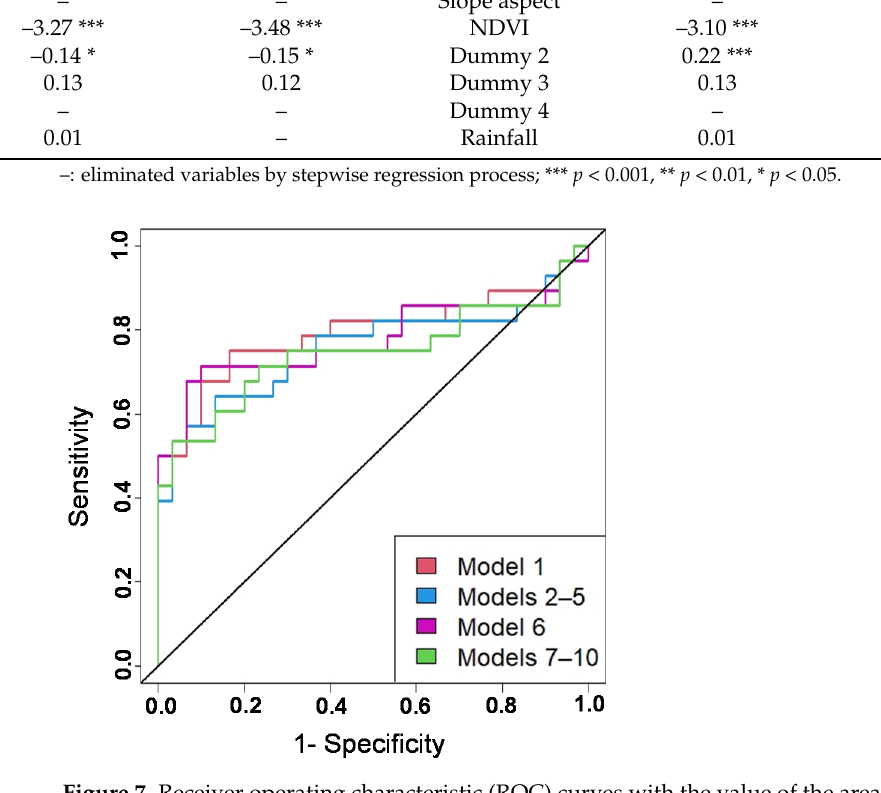
Figure 7. Receiver operating characteristic (ROC) curves with the value of the area under the curve (AUC) for all models developed by logistic regression analysis. Table 3. The values of the AUC, F1 scores, and overall accuracy for models 1–10 developed by logistic regression analysis.